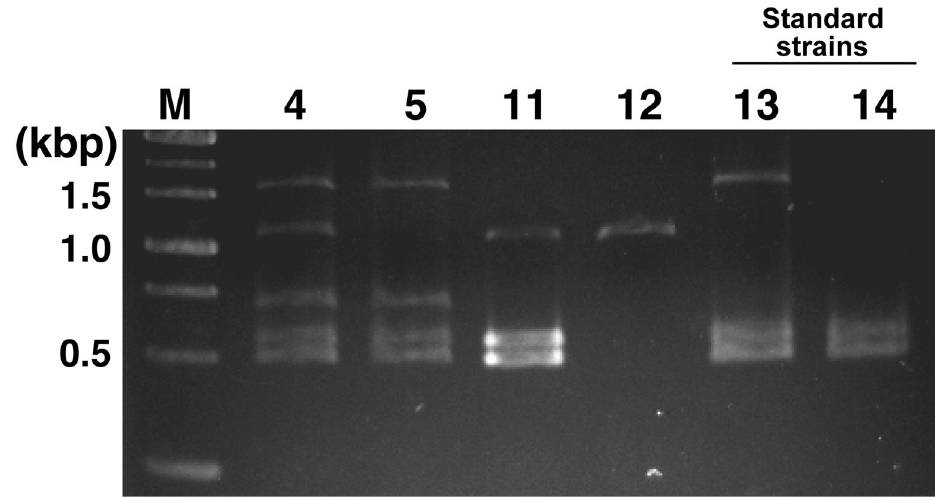
Fig 5. Multiplex PCR. Multiplex PCR results using template DNA from 6 strains (Nos. 4, 5, and 11–14) of P . caudatum . M, weight